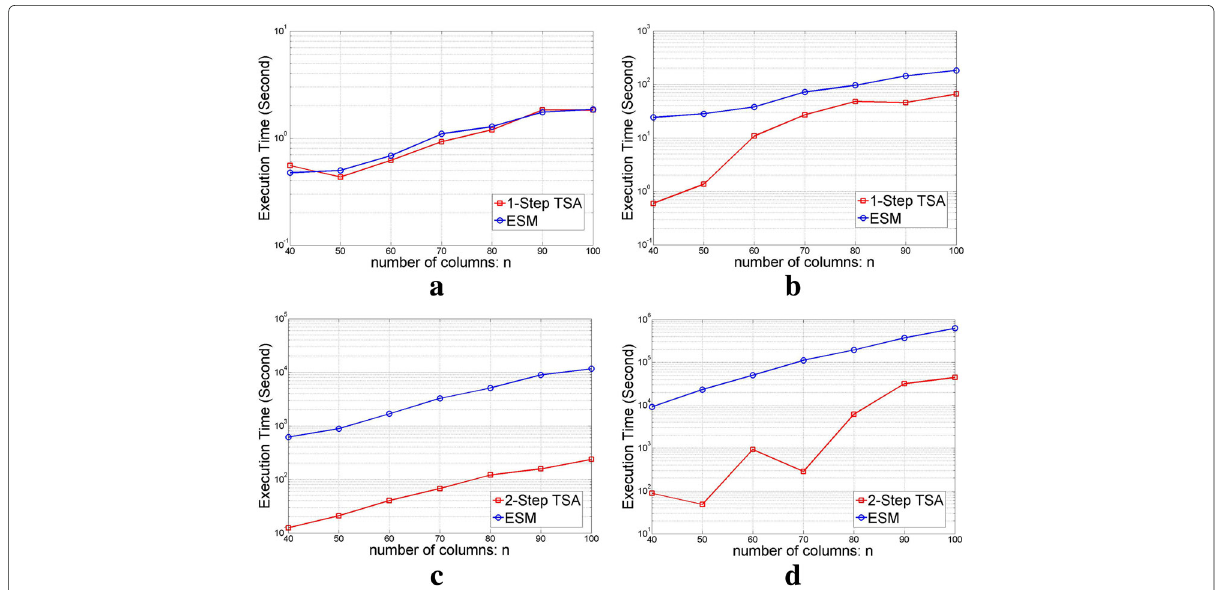
Fig. 4 The execution time of TSA in log scale as a function of n on randomly chosen m × n Gaussian matrices, where m = n / 2. a k = 1 b k = 2 c k = 3 d k =